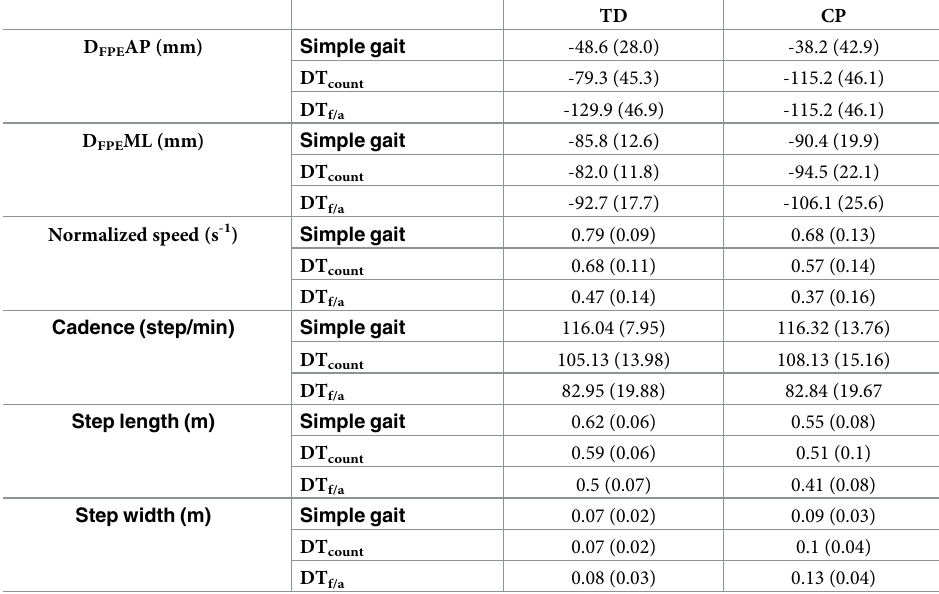
Mean (standard deviation) are presented for the simple task, the counting dual task (DT count ) and the fluency dual task (DT f/a ). The speed is normalized by leg length.second; min: Minute; m: